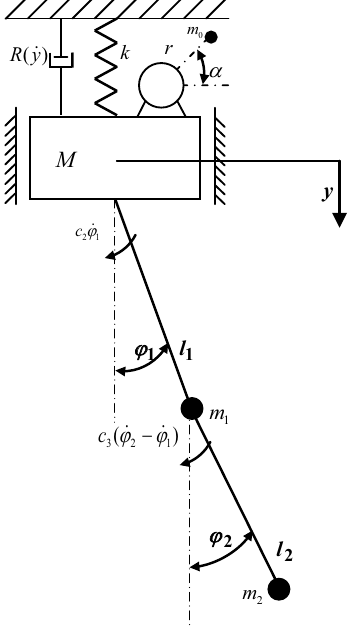
Fig. 1. Schematic diagram of